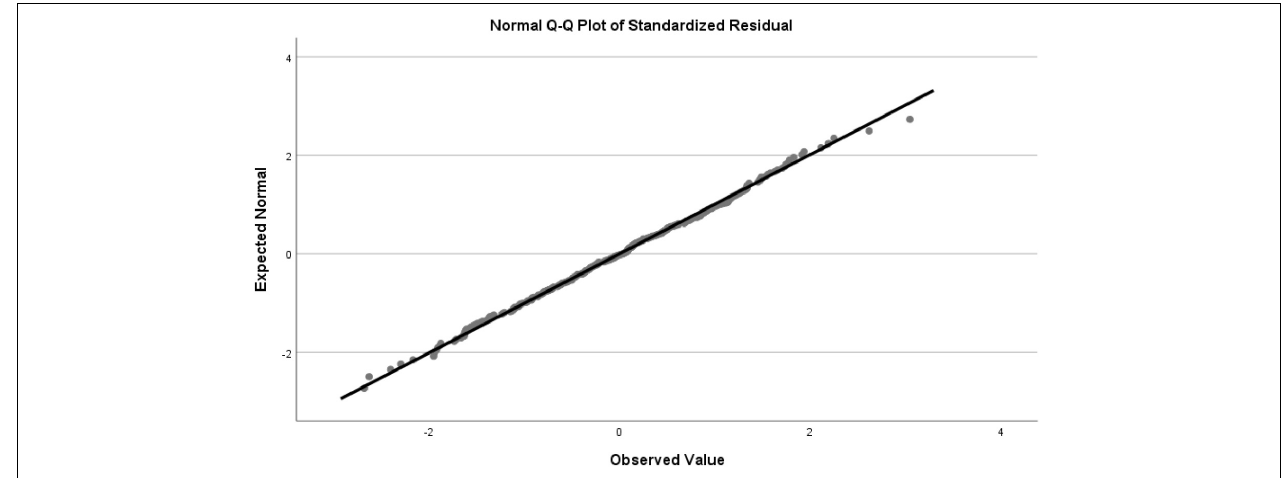
FIGURE 2 | QQ plot graph of the normality of the